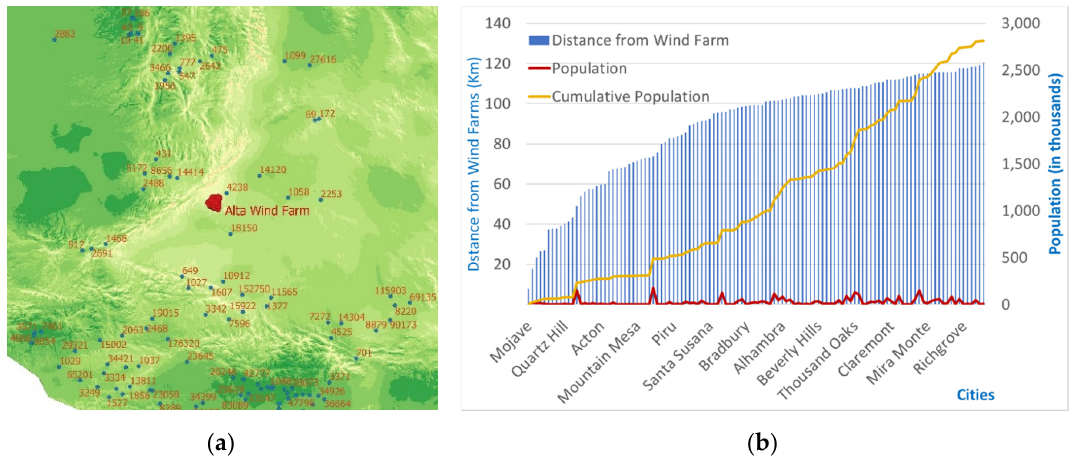
Figure 8. Cities (with population label) close to the Alta Wind Farm. ( a ) Location map; ( b ) Geographic Information System (GIS) proximity and population analyses.